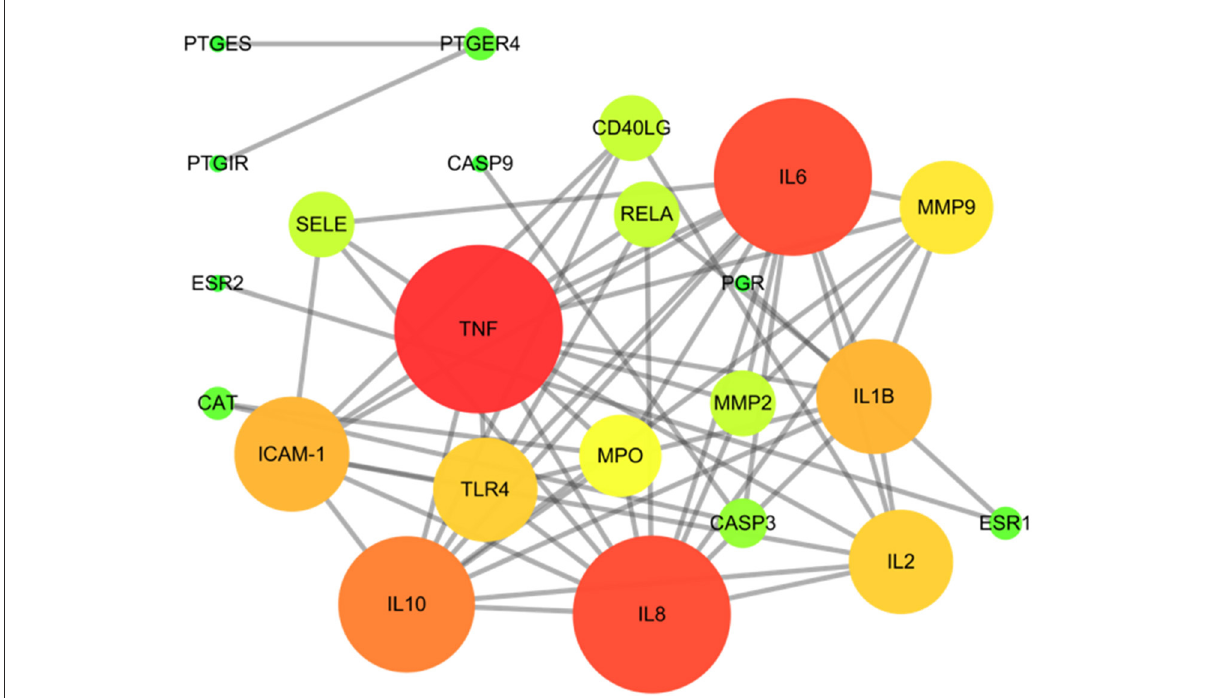
FIGURE3 Protein–protein interaction (PPI) network of SOL in treating endometritis. Different colors (from red to green) and the size (from large to small) indicate the